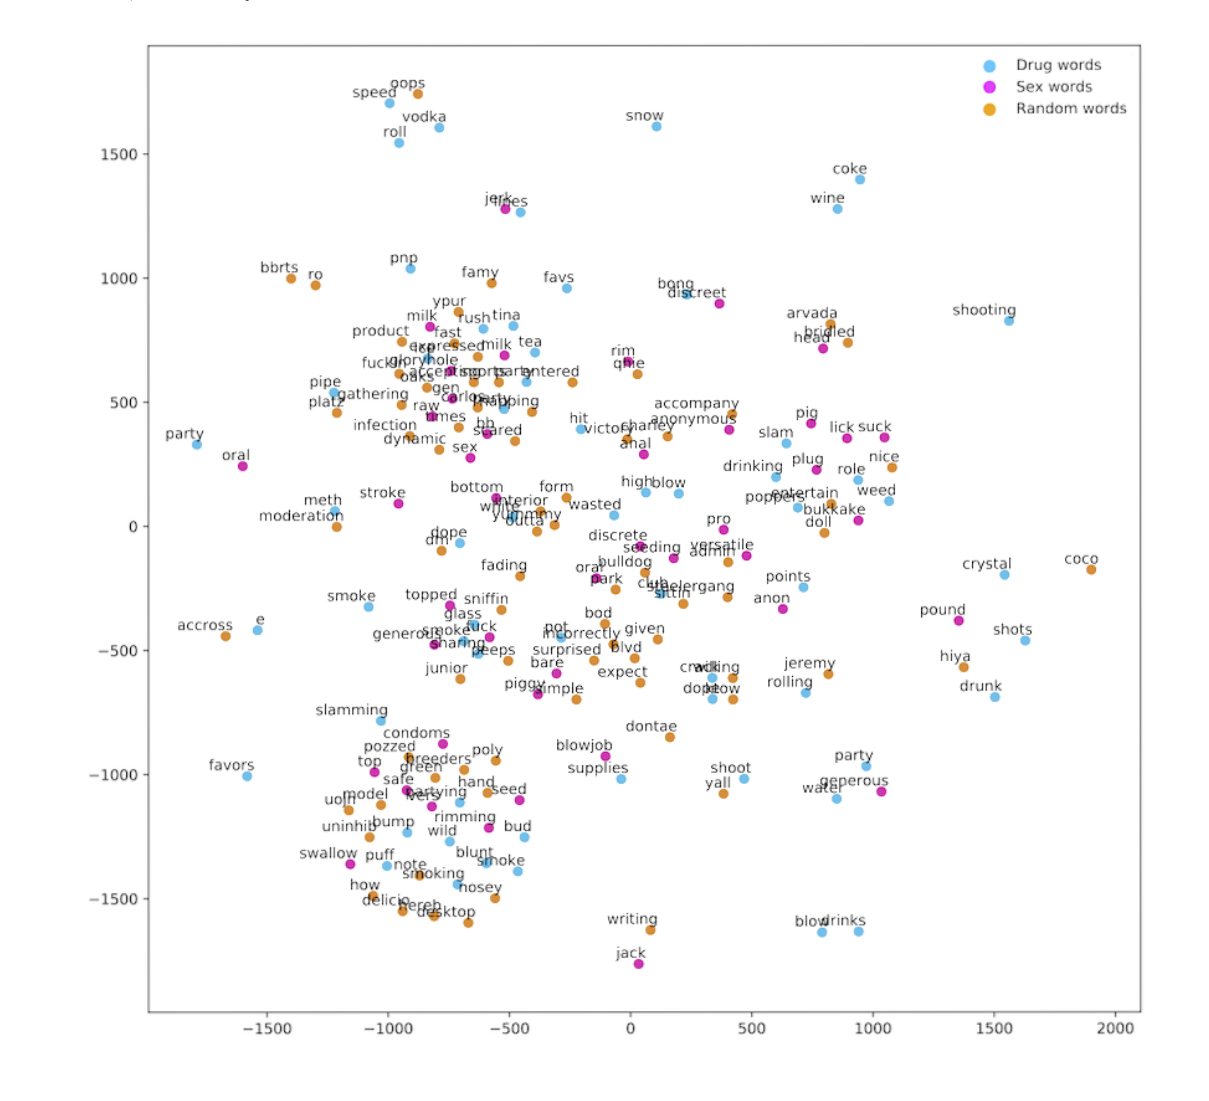
Figure 5. A t-distributed stochastic neighbor embedding visualization of the resulting vector space after running Word2Vec: drug-related words, sex-related words, and randomly chosen